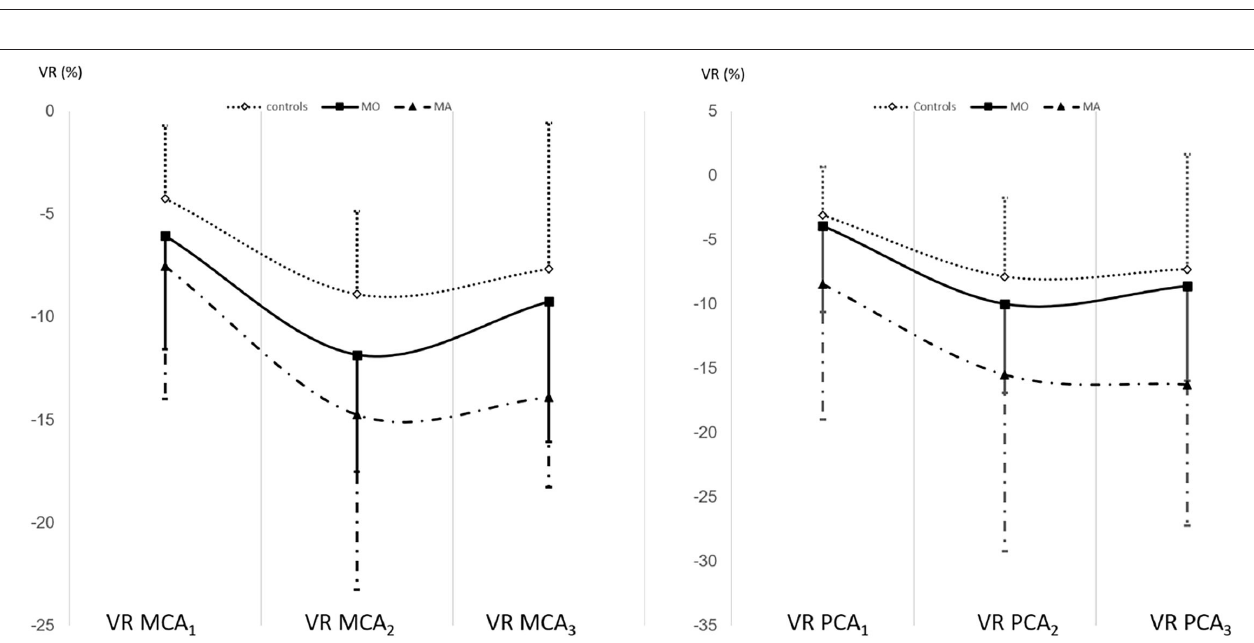
FIGURE 2 | The VR MCA and VR PCA in MO and MA compared to the control group separately.